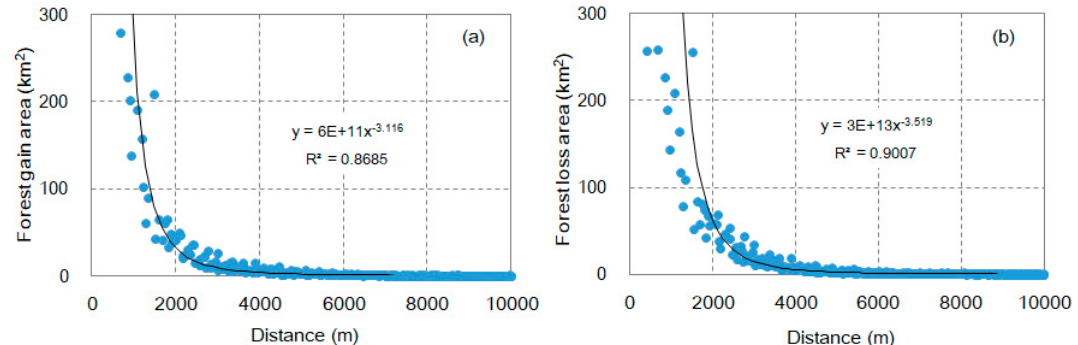
Figure 10. Forest changes analyzed by accessibility to roads: forest gain ( a ) and forest loss ( b ).